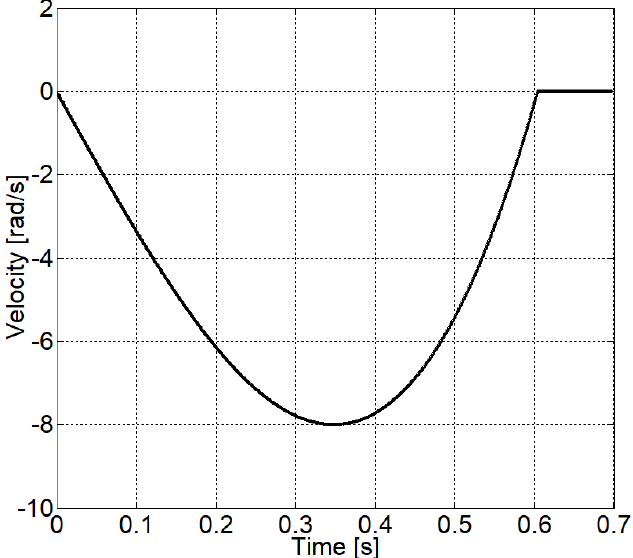
Figure 8. System’s velocity with the velocity